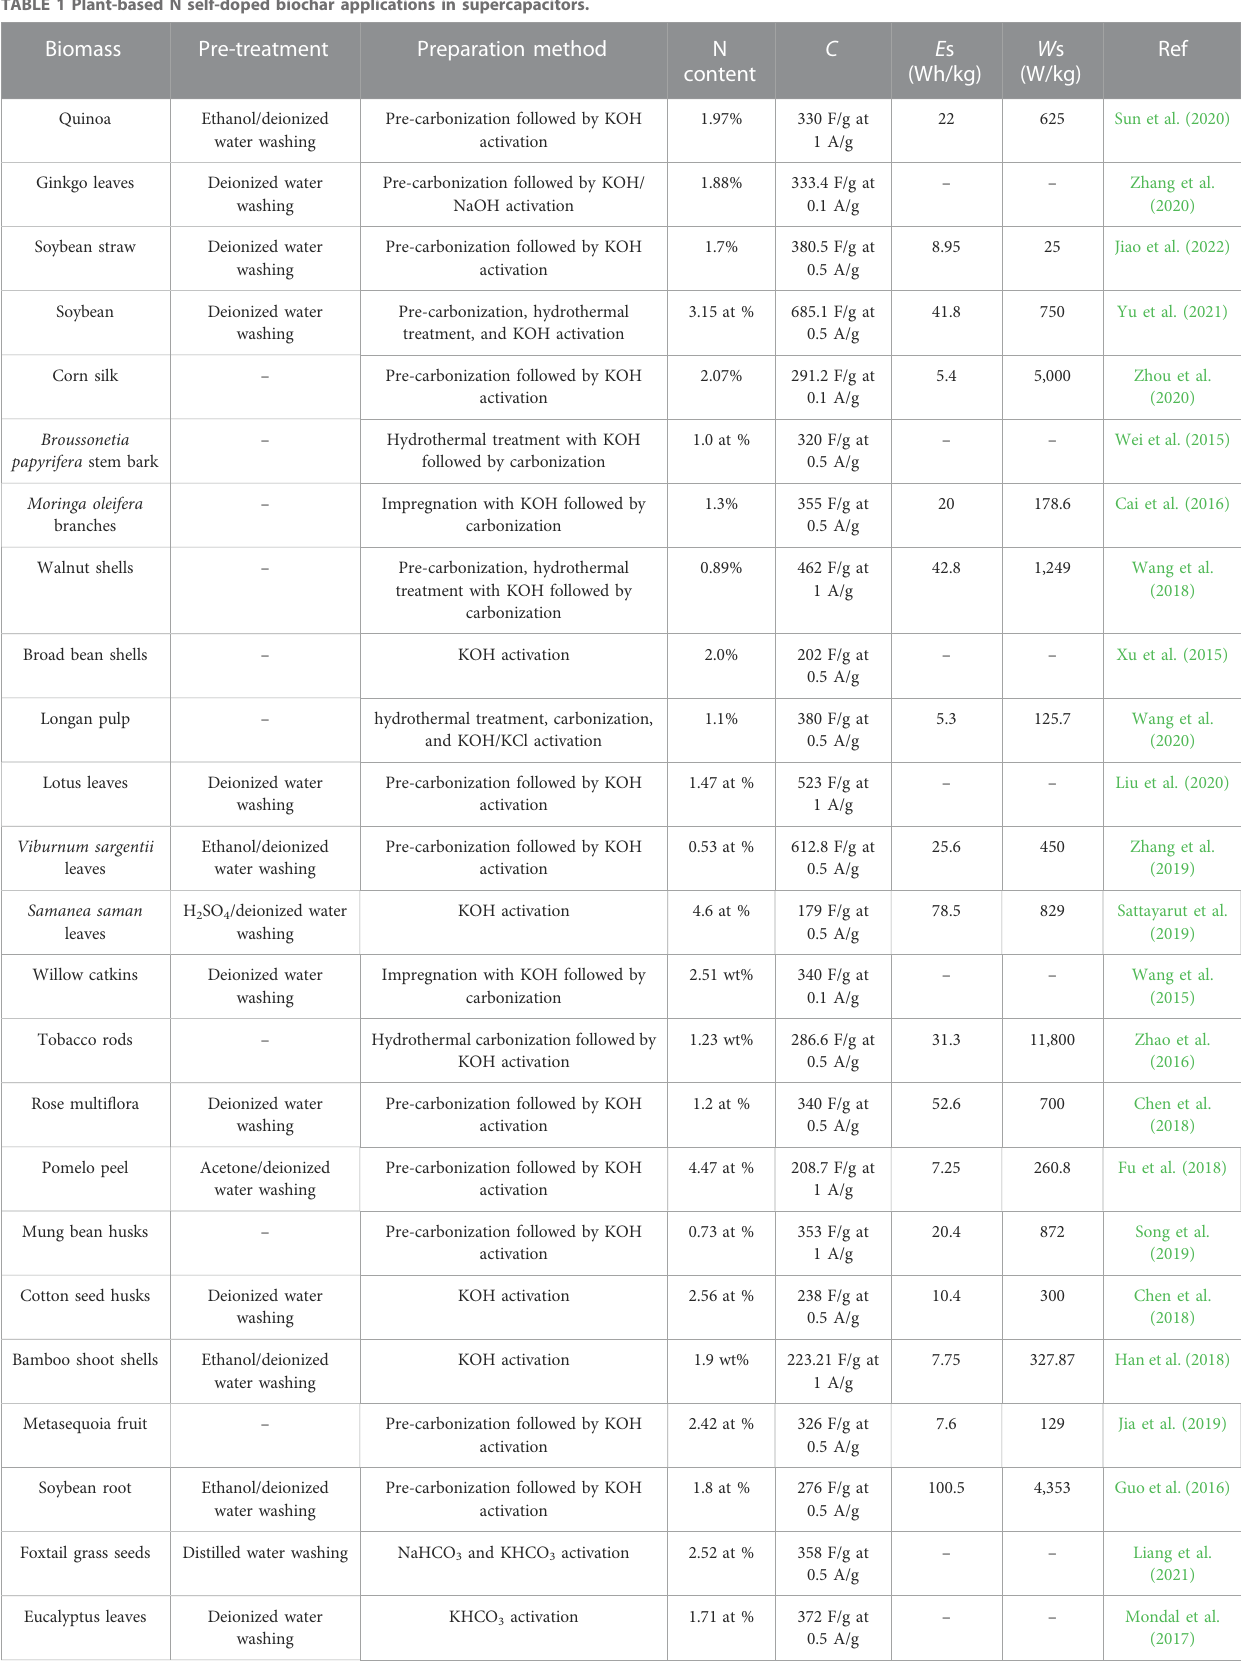
TABLE 1 Plant-based N self-doped biochar applications in